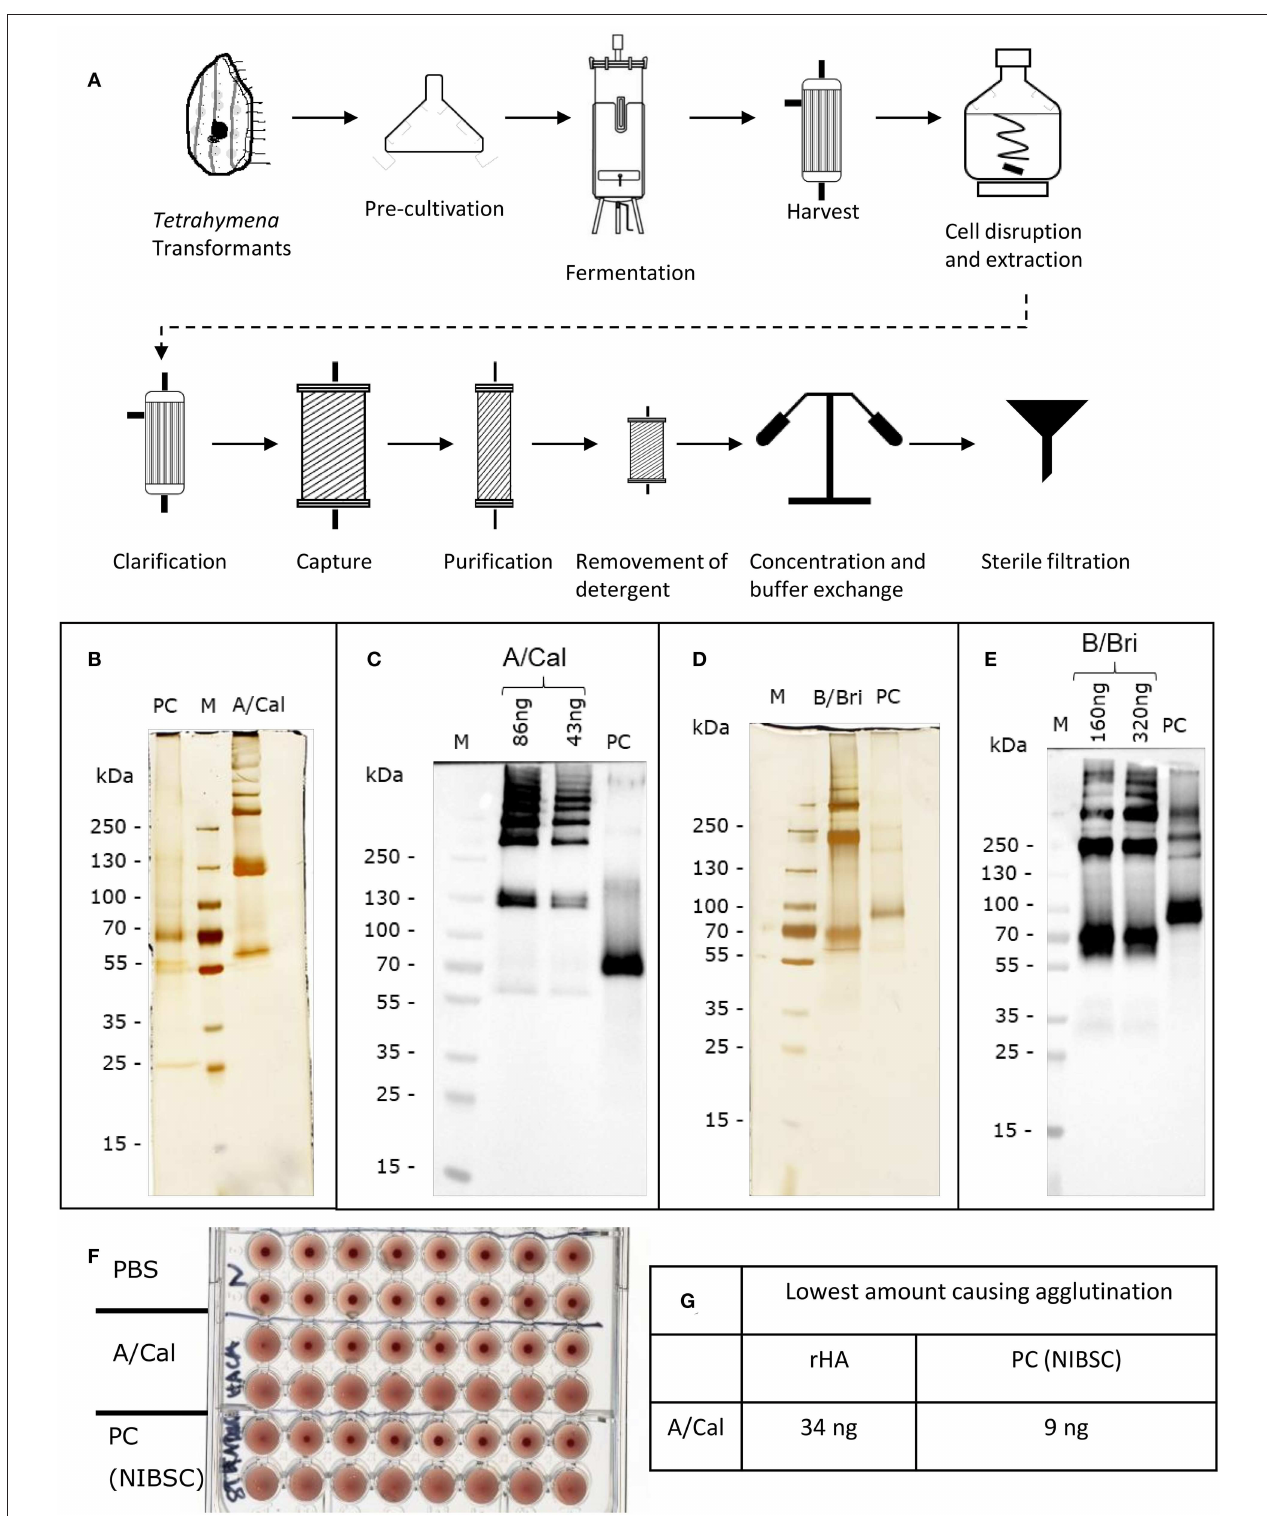
FIGURE 1 | Production and characterization of recombinant rHA expressed in Tetrahymena thermophila. (A) Schematic of production and purification; see Table S1 for details of conditions used for different rHA. Each purified rHA was analyzed by SDS-PAGE and silver staining (B,D) or Western blot (C,E) . A/Cal, ciliate